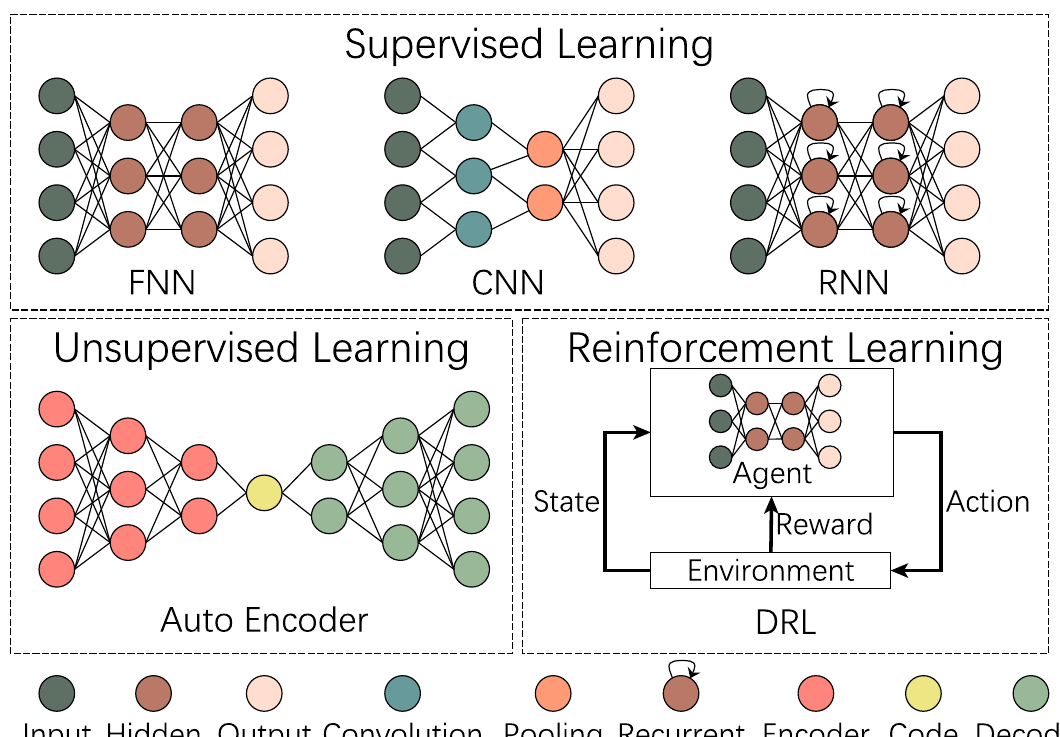
Figure 3. Typical deep neural network (DNN)